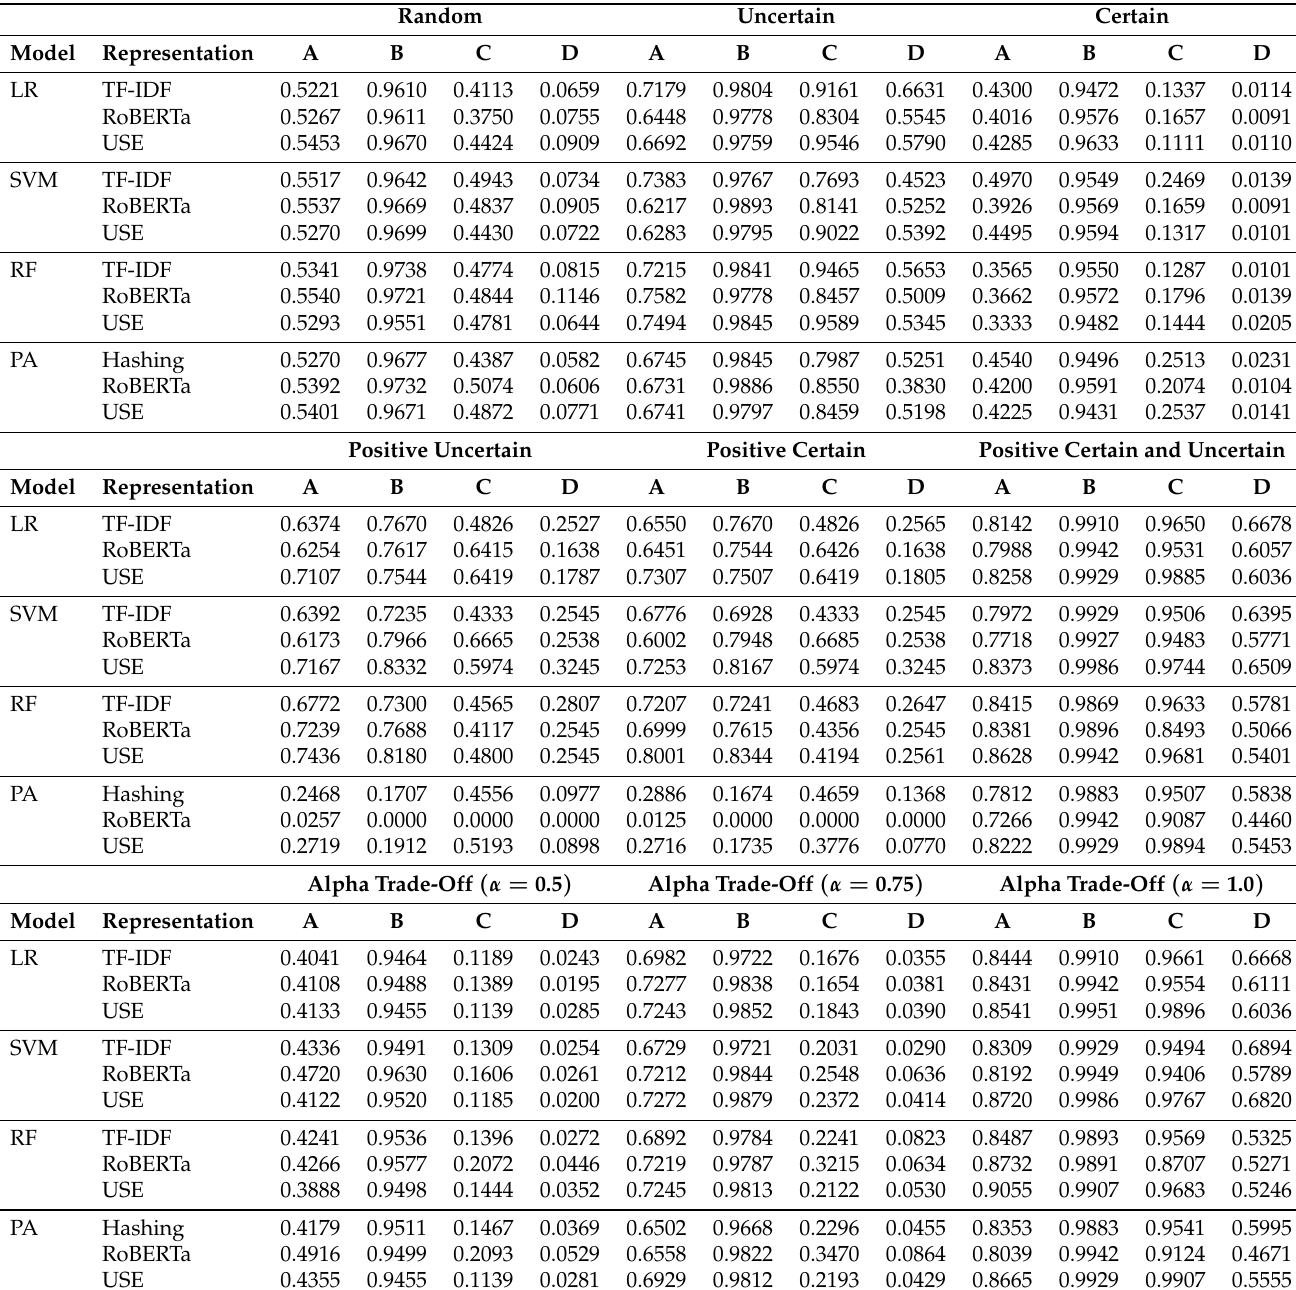
Table A4. Recall scores for all